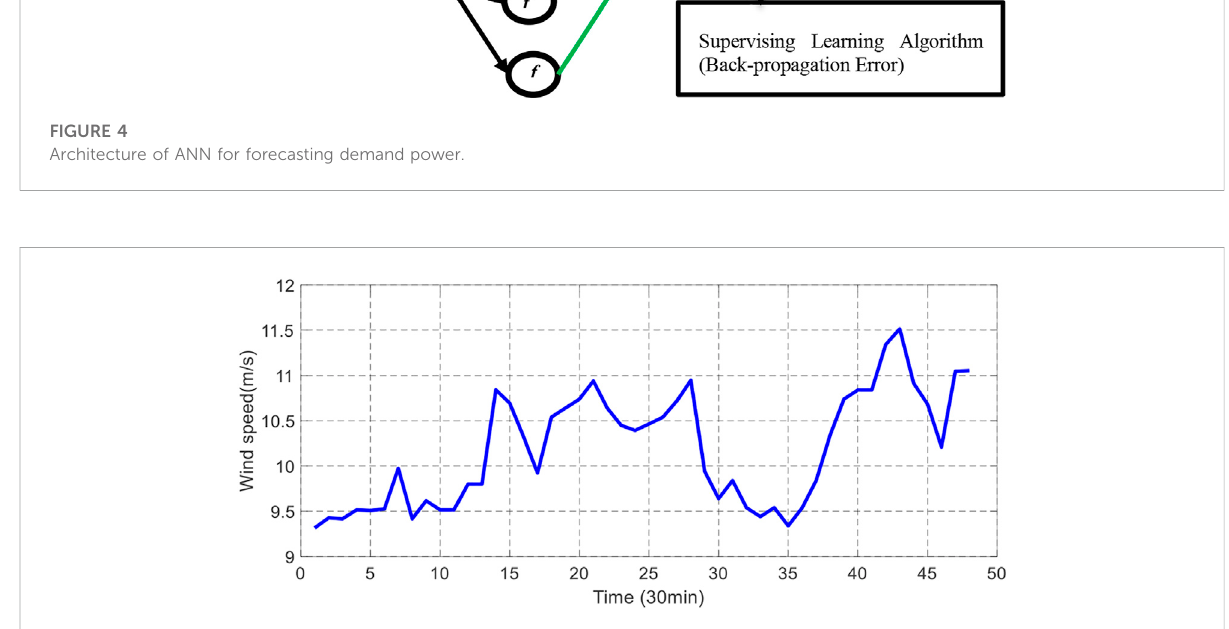
FIGURE 5 Wind speed pro fi le (1